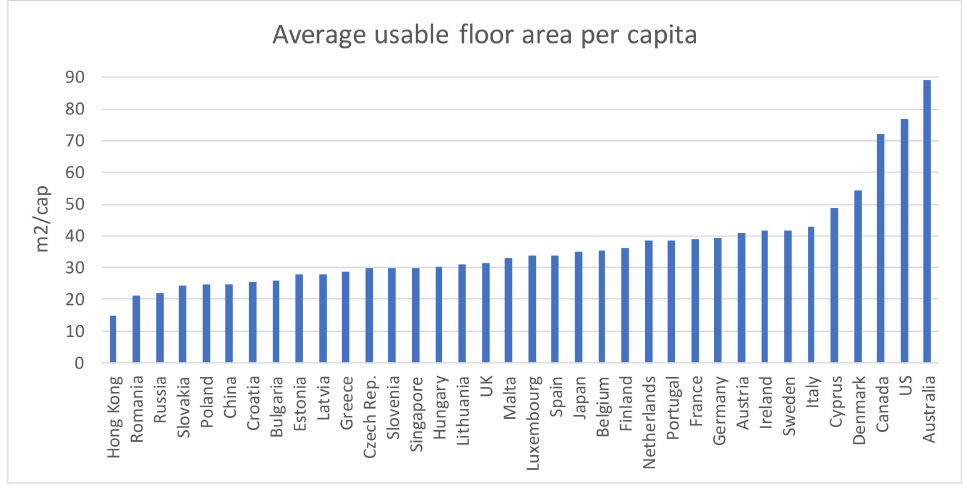
Figure 2. Average floor area per capita in residential buildings worldwide as of 2008. Data collated and synthesised from